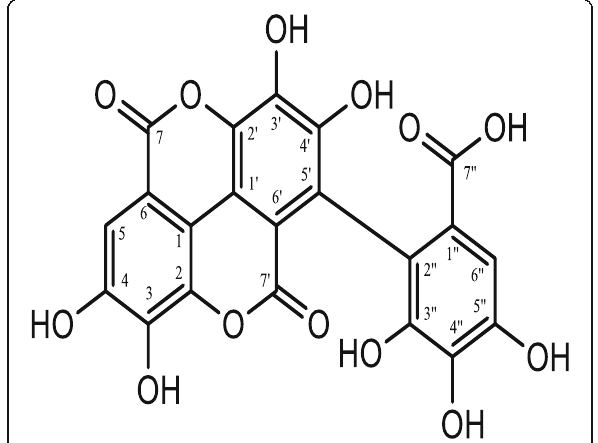
Fig. 2 Flavogallonic acid dilactone. Tan powder. LC-MS (negative ion mode) m/z : 469 (M-H); 1 H – NMR (in CD 3 OD): δ (ppm) 7.26 (s), 7.50 (s). δ (ppm) 108.1 (C-1, 1 ′ ), 110.1 – 114.4 (C-6, 6 ′ ), 13 C – NMR (in CD 3 OD):